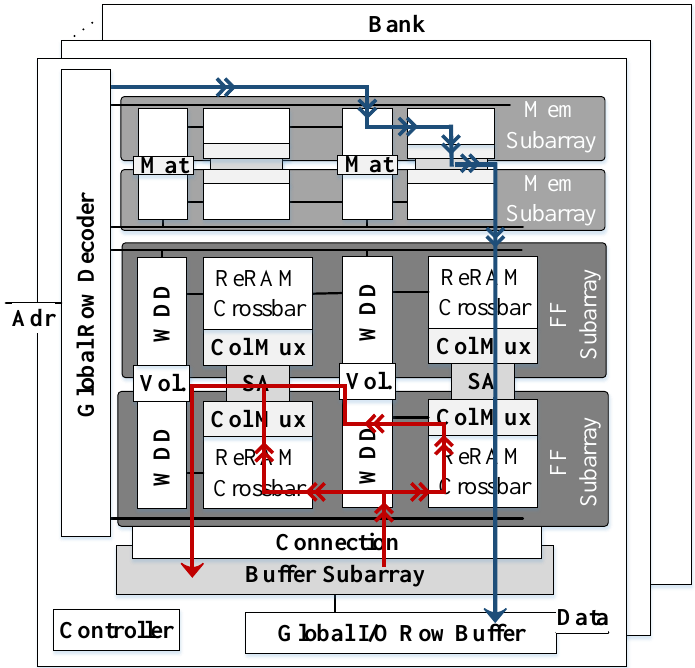
Figure 19. Overview of the PRIME architecture (adapted from